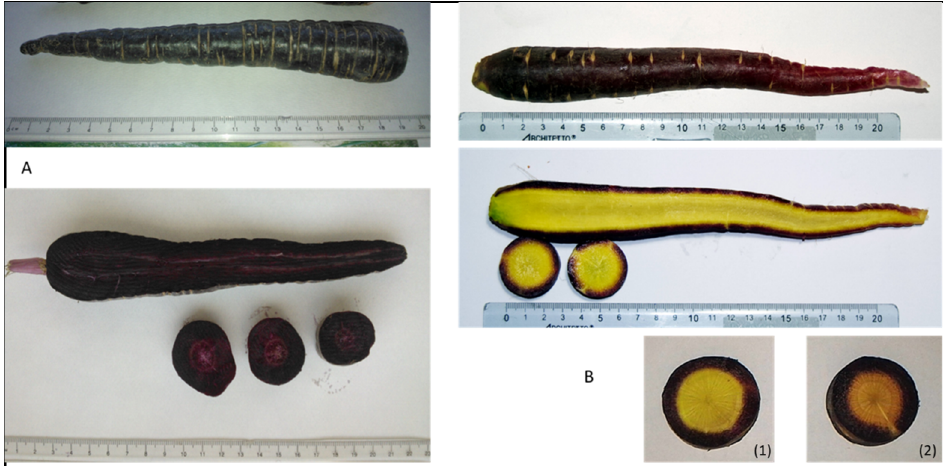
Figure 2. Whole and sectioned carrots (longitudinal and cross-sections). ( A ) Black carrot (BC). ( B ) “Polignano” carrot (PC); cross-sections of different types of PC are also shown, with yellow core ( 1 ) or orange-purplish core ( 2 ).